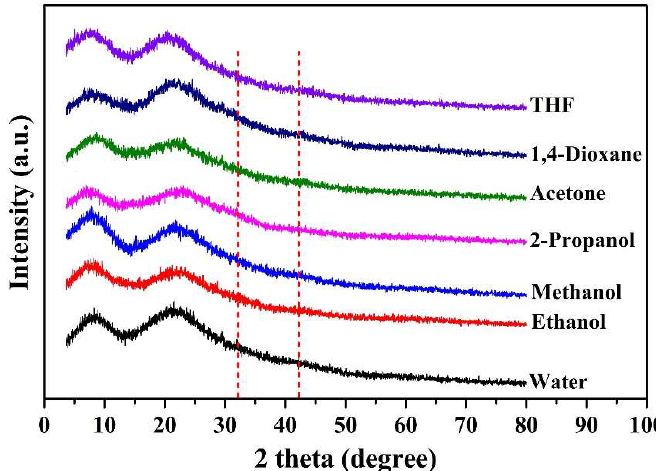
Figure 3. XRD patterns of PGG when PGG solution was mixed with six organic solvents (PGG solution/solvent v/v =